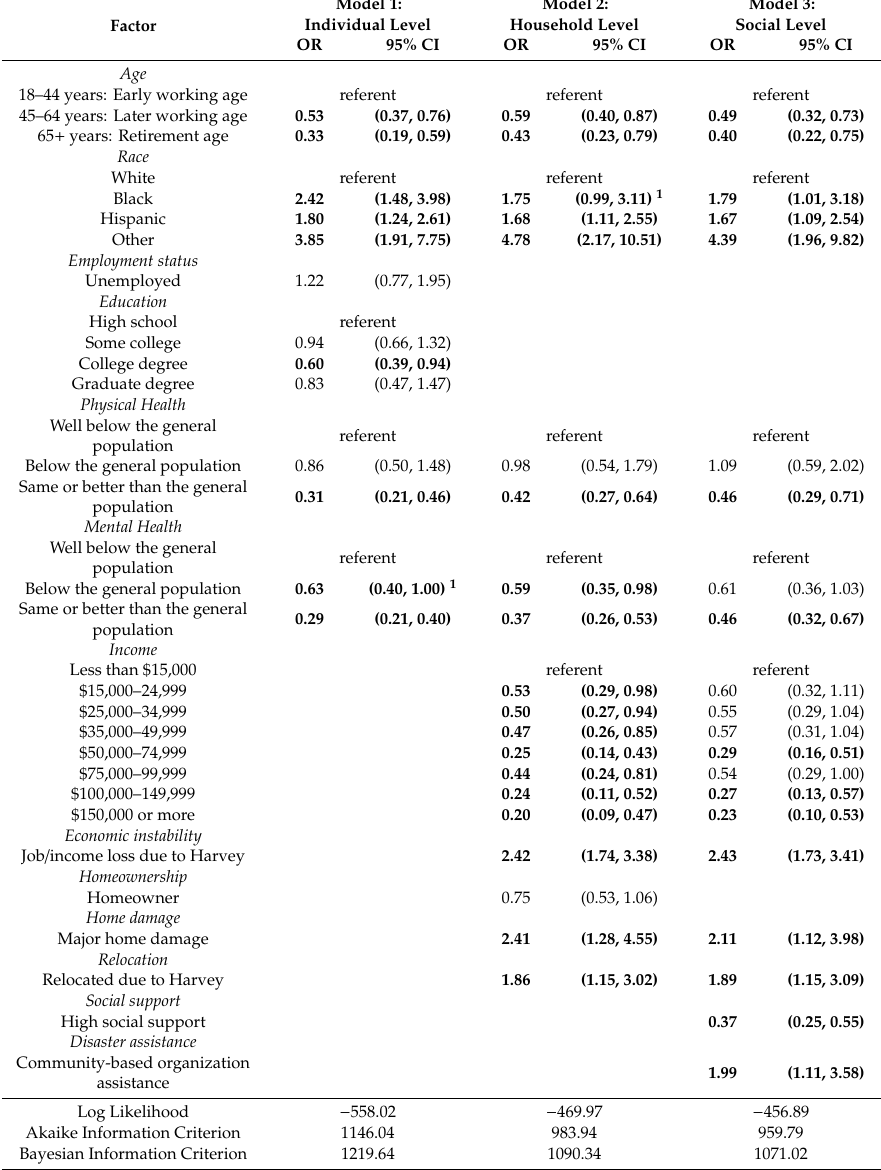
Model 1: Individual Level